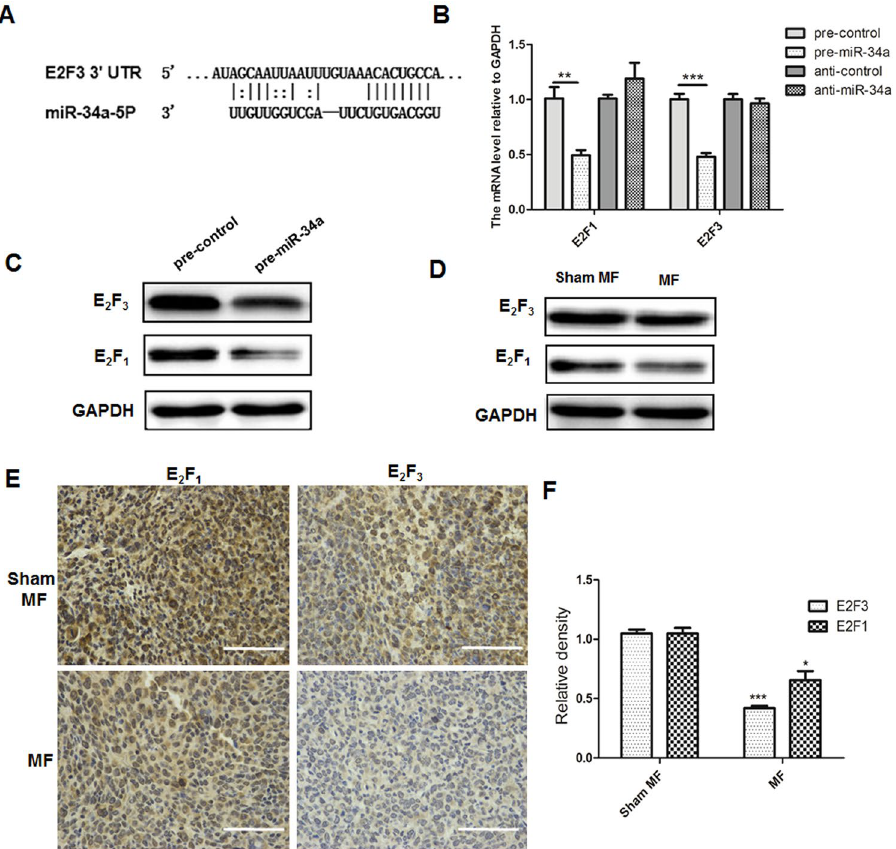
Figure 4. MiR-34a inhibits lung cancer growth via modulation of the E2F pathway. ( A ) Predicted miR-34a target sequence in the 3 ′ UTR of E2F1 and E2F3. ( B ) Q-PCR analyzes the mRNA levels of E2F3 and E2F1 in LLC cells transfected with synthetic pre-miR-34a, pre-control, anti-control and anti-miR-34a for 48 h. ( C ) Western Blot analyzes E2F3 and E2F1 expression in in LLC cells transfected with pre-miR-34a and pre-control for 48 h. The numbers under each blot are relative intensity of the blot. ( D ) Western Blot analyzes E2F3 and E2F1 expression in LLC cells after treating with MF and Sham MF for 6 days. Relative intensity of the blot was added under each blot. ( E ) E2F3 and E2F1 expression in tumor tissue of LLC murine model was detected using IHC staining; Scale bars, 100 µ m. ( F ) IHC images were calculated using Image Pro Plus software 6.0. All experiments were repeated three times. Data represent Mean ± SEM. * P < 0.05, ** P < 0.01, *** P <